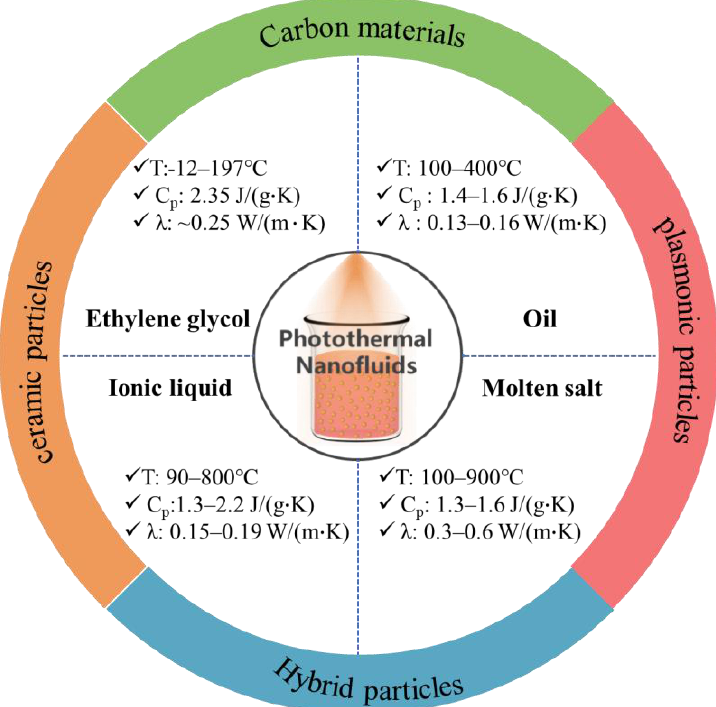
Figure 2. Representative thermal storage fluids and solar absorbers for preparing medium-temrature solar-thermal nanofluids.